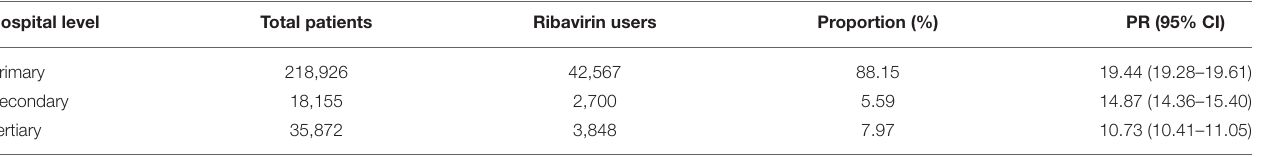
TABLE 2 | Prevalence of ribavirin users in different level of